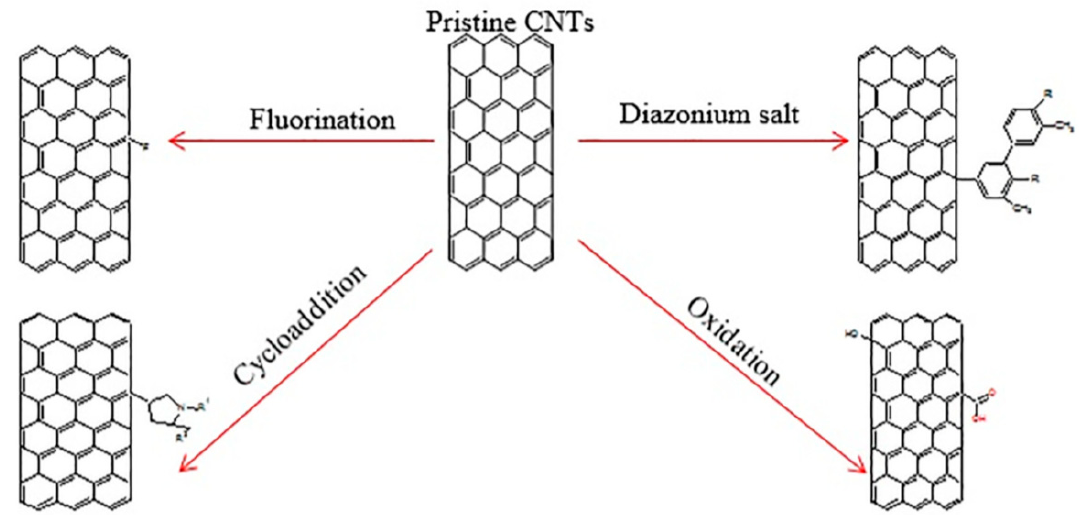
Figure 6. Chemical modifications of carbon nanotubes (CNTs). Reproduced from Reference [78], with permission from Elsevier, 2018.